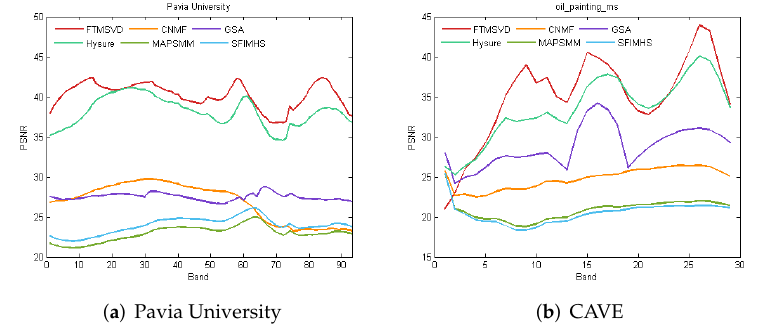
Figure 7. The PSNR of each spectral band for the compared methods using SRF1 and